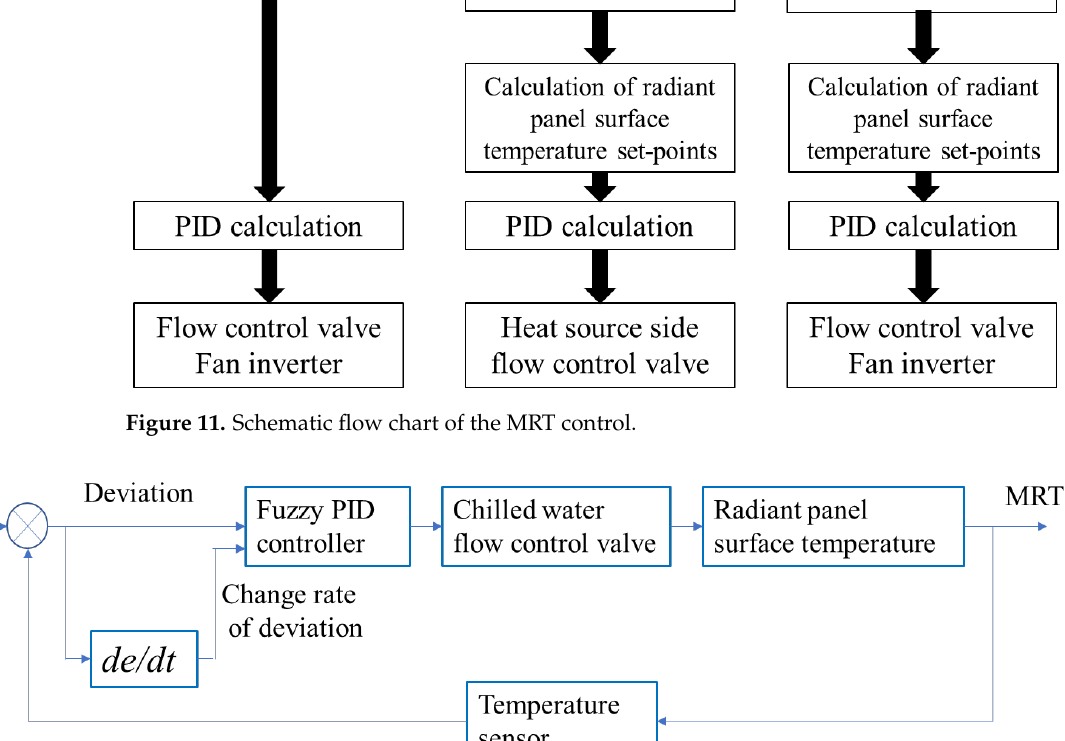
Figure 11. Schematic flow chart of the MRT control.